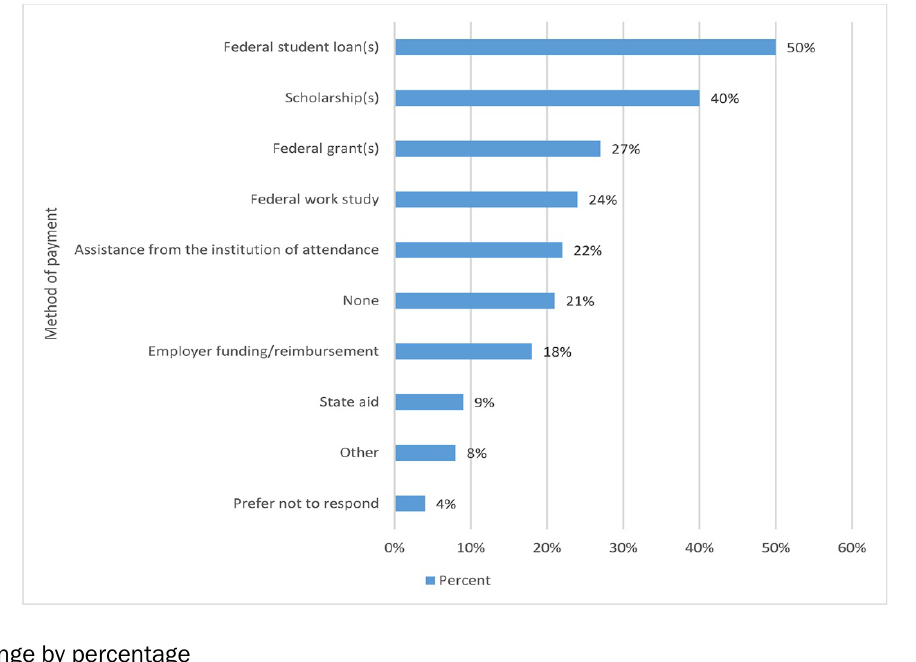
Figure 8 Financial aid by percentage